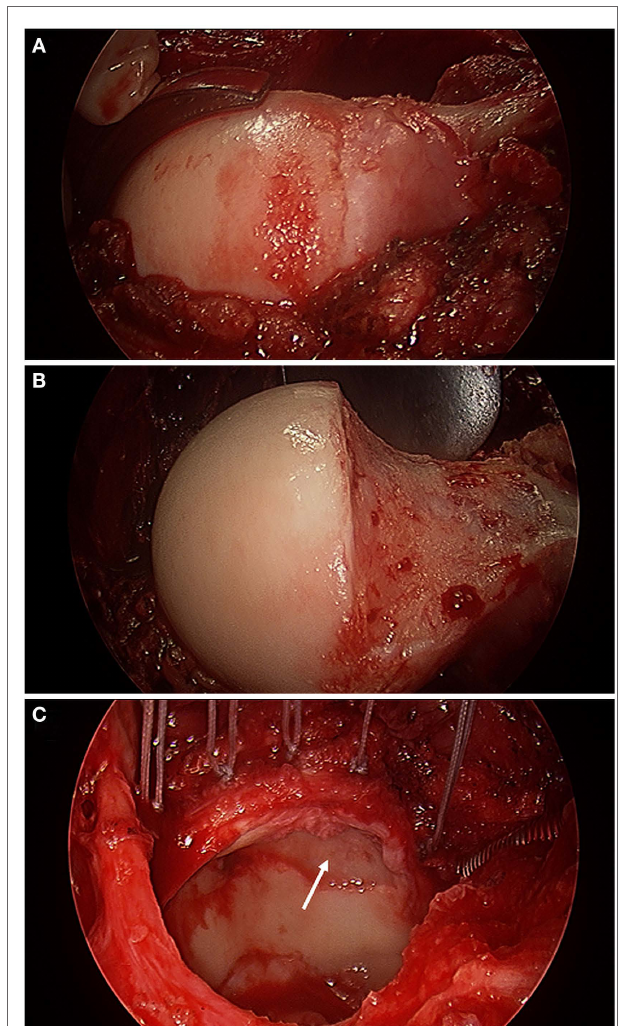
FiGURe 3 | intra-operative photographs made with an arthroscopic surgery camera after surgical hip dislocation demonstrating a bump deformity at the femoral head–neck junction (A), the femoral head– neck osteochondroplasty to improve the femoral head–neck offset (B), and acetabular evaluation under full direct visualization revealing full-thickness chondral damage at the anterior–superior aspect of the acetabulum (white arrow) and an extended torn labrum that was re-attached to the acetabular rim with five suture anchors (C) in a 56-year-old with